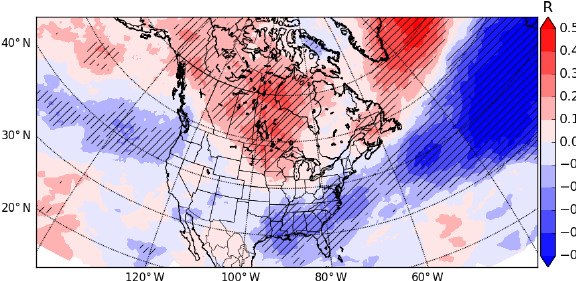
Figure 8. Track density correlation with the monthly NAOI in win- ter (DJFM). Hatched areas represent statistically significant values at the 0.05 level.